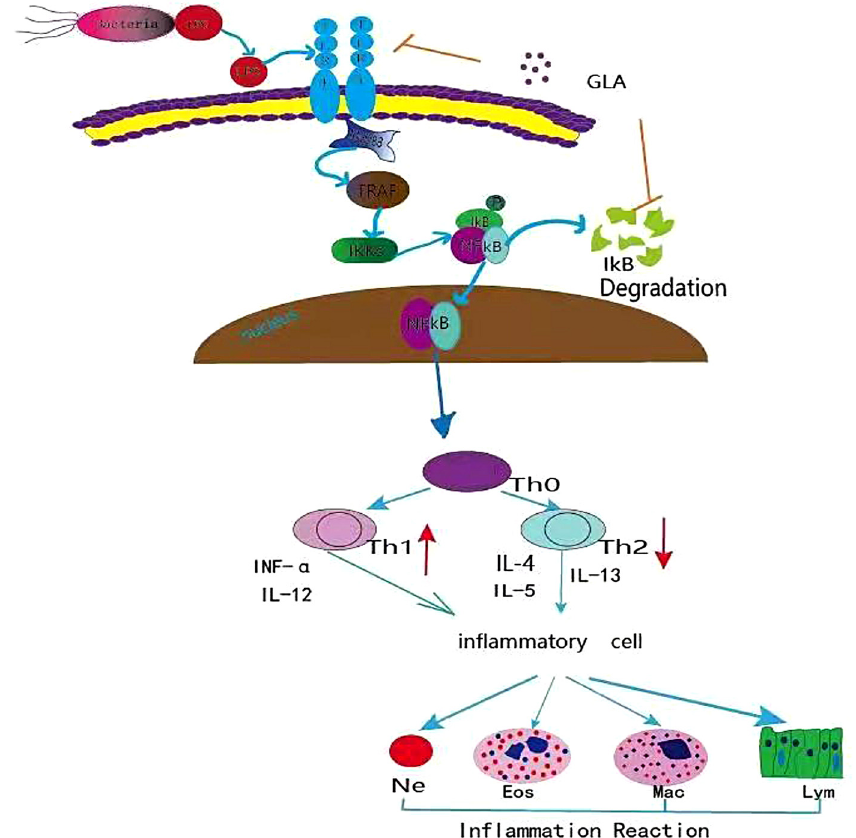
Figure 13: Schematic diagram of the role and mechanism of GLA in asthmatic in fl ammation. GLA could inhibit the airway in fl ammatory of asthmatic mice. This e ff ect might be through the downregulation of the expression of TLR4/NF - κ B signaling pathways; the inhibition of IL - 4, IL - 5, IL - 13, TNF - α , IL - 6, and IL - 1 β ; and the enhancement of IL - 12 and IFN - γ levels, as well as in fl ammatory response mediated by neutrophils, eosinophils, macrophages, and